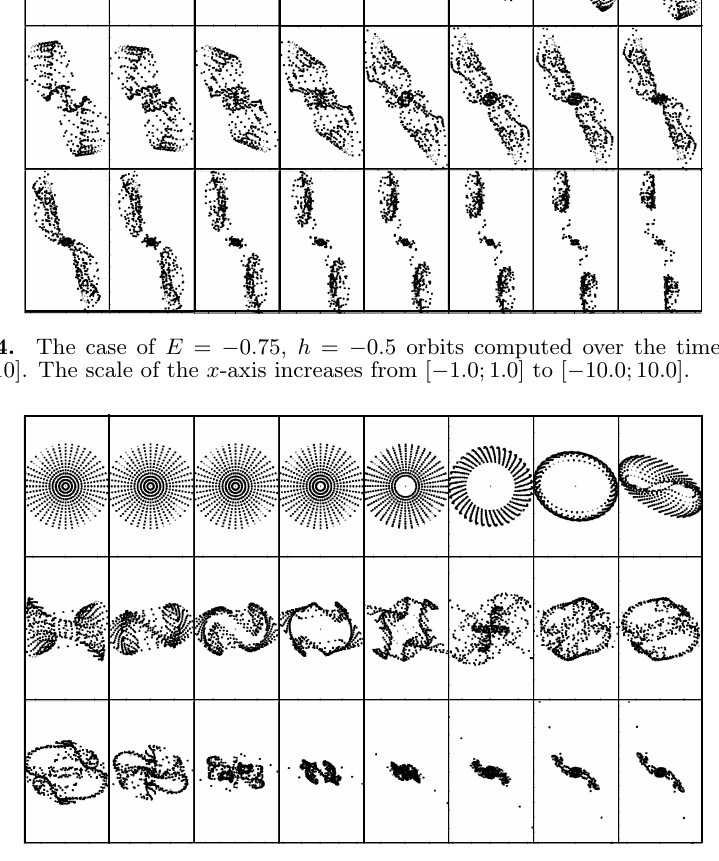
Fig. 5. The case of E = (cid:0) 1 : 2, h = 0 orbits computed over the time interval (cid:28) = [0 ; 10]. The scale of the x -axis increases from [ (cid:0) 0 : 6; 0 : 6] to [ (cid:0) 5 : 5; 5 : 5] and that of the y -axis, from [ (cid:0) 1 : 0; 1 : 0] to [ (cid:0) 10 : 0; 10 : 0]. Most of the stars remain inside the cluster, only a few stars dissipate starting from (cid:28) (cid:25)